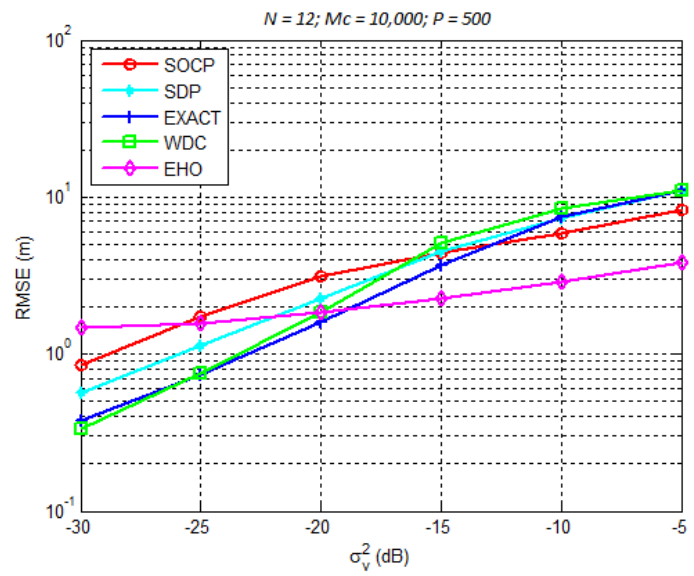
Figure 9. RMSE (m) versus σ 2 ν